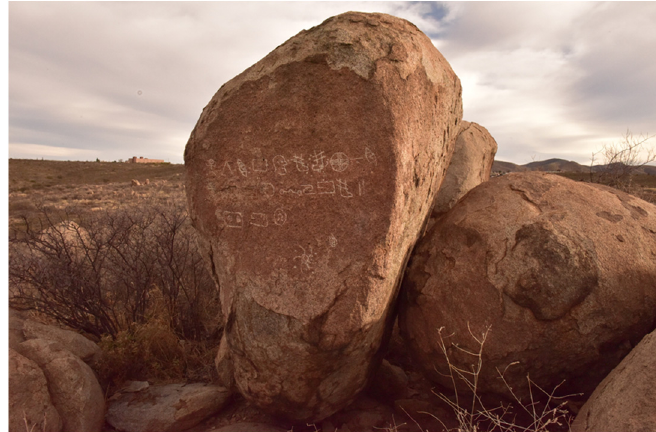
Figure 16. Tombstone, Arizona Western Message Petroglyph site.